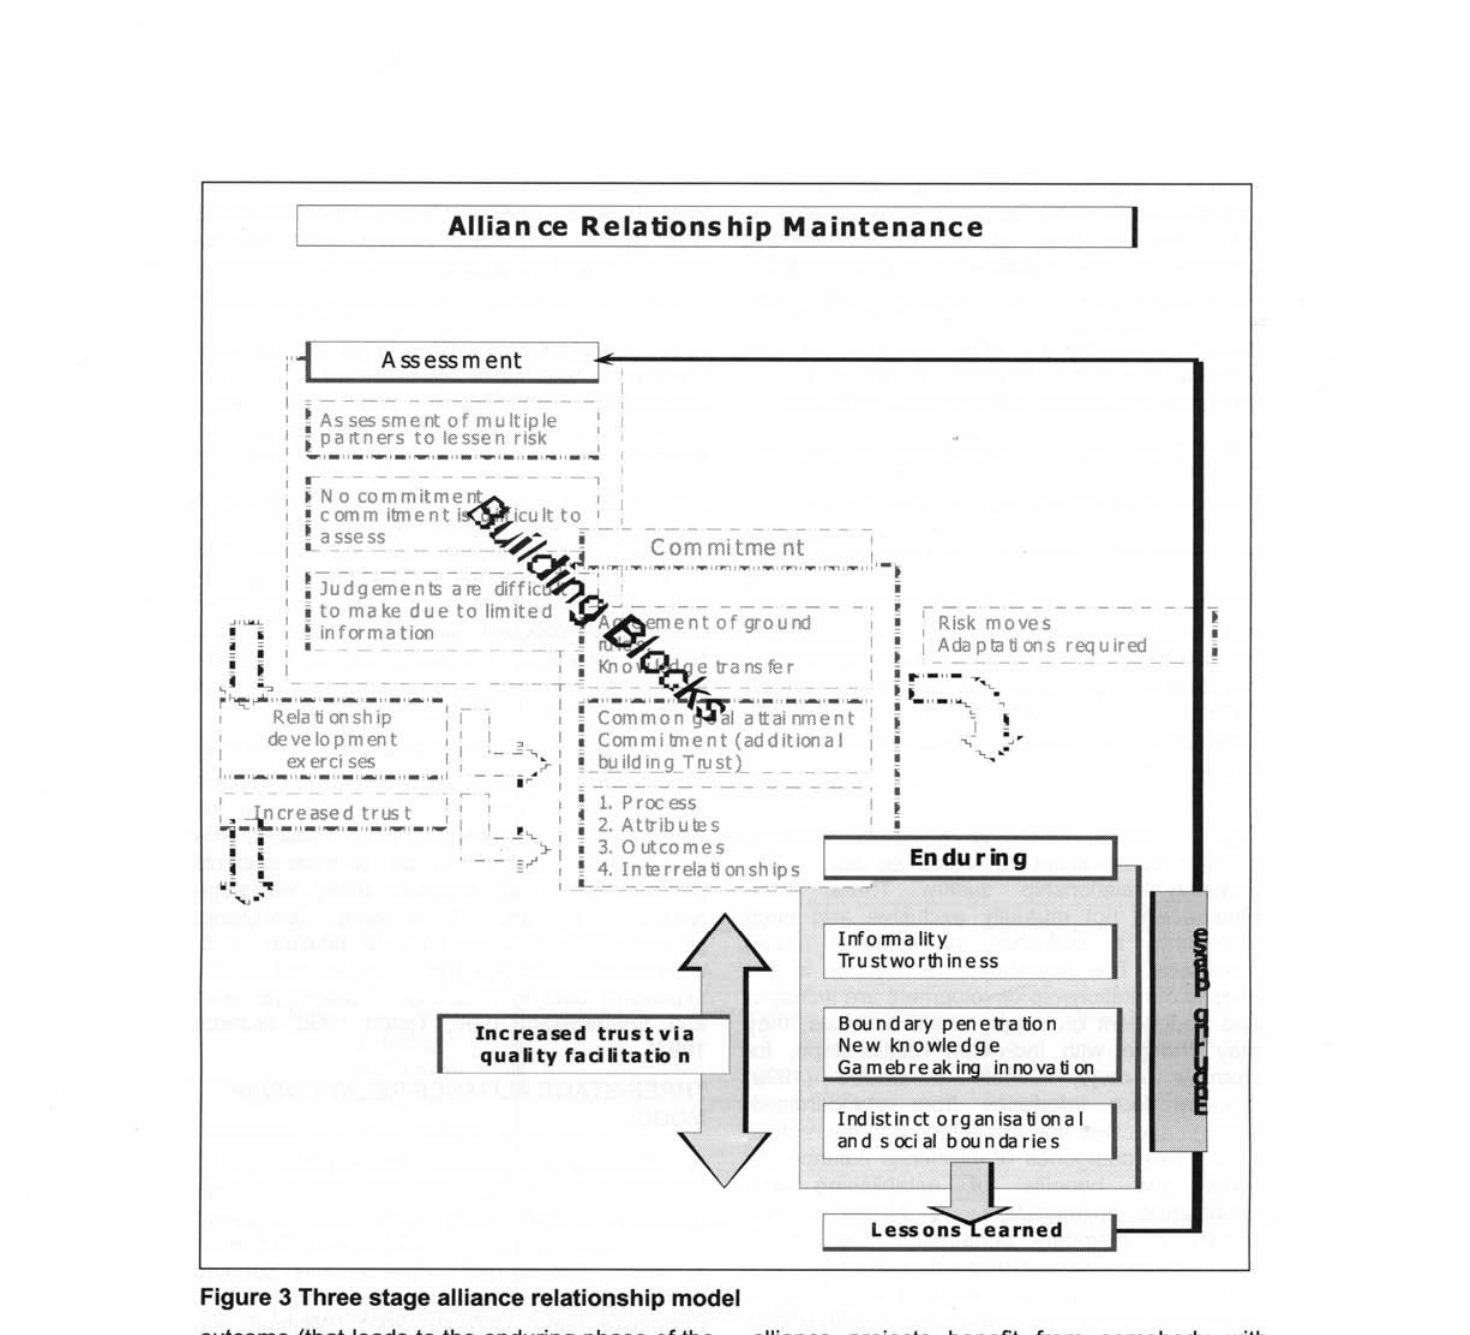
Figure 3 Three stage alliance relationship model outcome (that leads to the enduring phase of the relationship) and interrelationships (both individual and organisational) (Davis